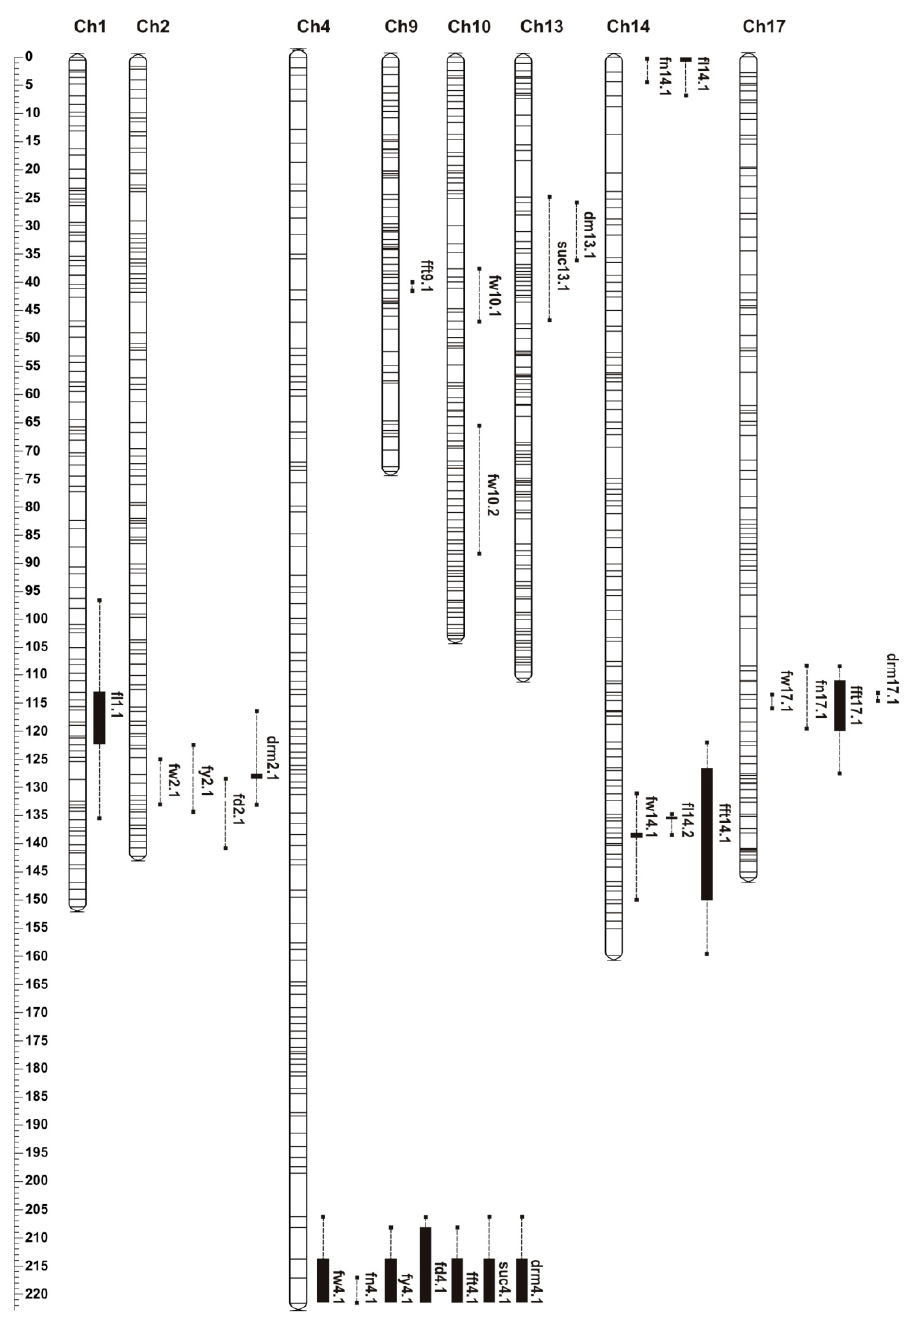
Figure 3. Chromosome localization of fruit-associated quantitative trait loci (QTLs) in Cucurbita maxima . Bars and whiskers represent identified QTLs. Black bars denote significant QTLs at p ≤ 0.05, while whiskers represent QTLs with maximum logarithm of odds (LOD) values below the threshold, detected in both experiments with PVE > 7%. Scale in cM.